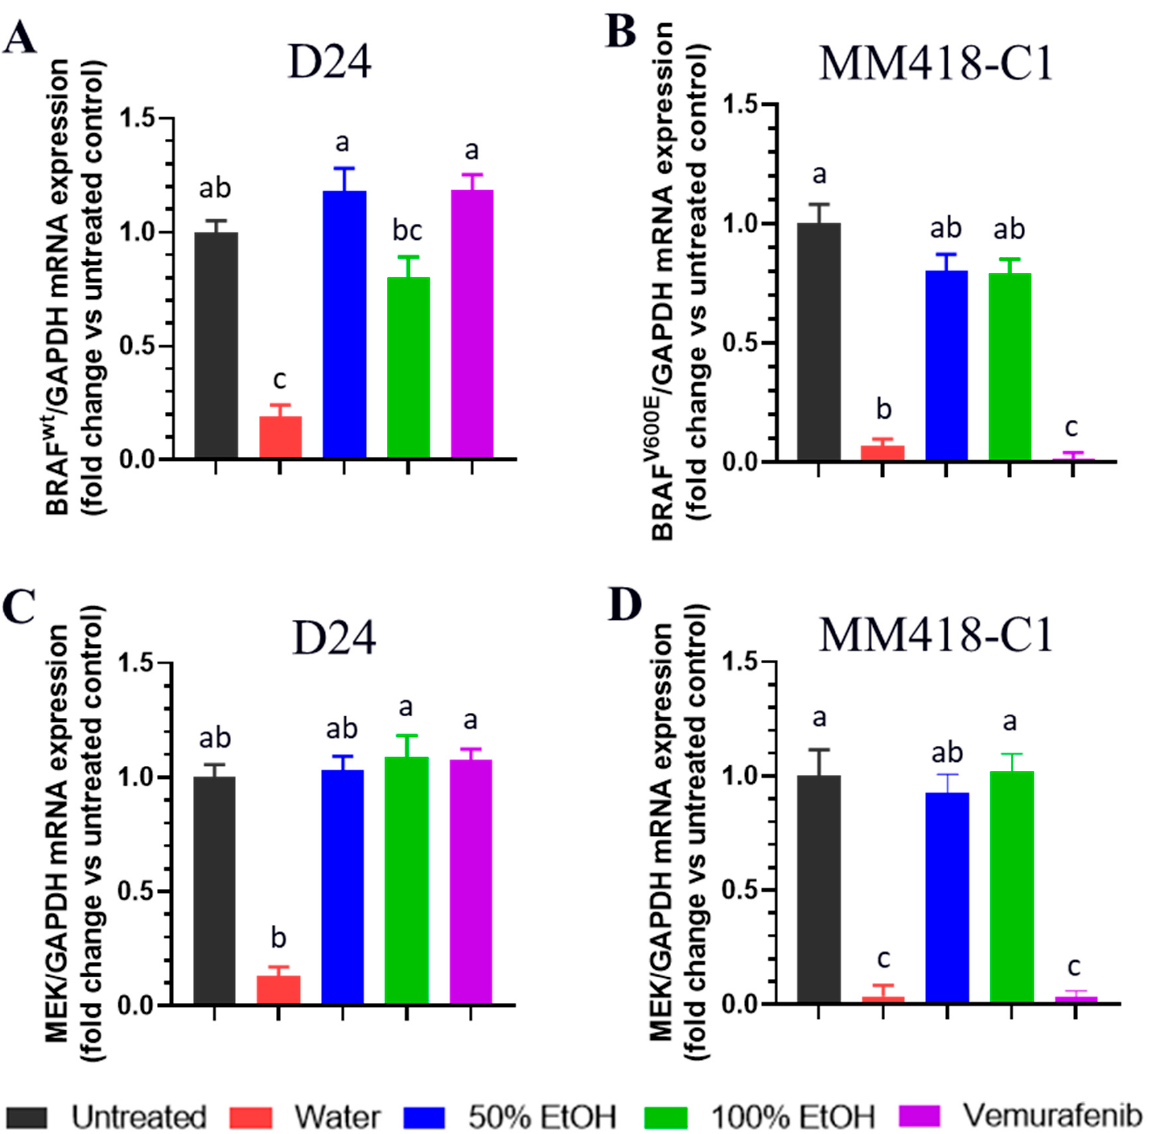
Figure 5. Effect of M. cochinchinensis seed extracts on the expression of BRAF WT gene in D24 ( A ), BRAF V600E gene in MM418-C1 ( B ), and MEK1 genes in D24 ( C ) and MM418-C1 ( D ) melanoma cells. The cells were treated with 100 µg/mL of the different seed extracts or vemurafenib for 48 h prior to RNA collection. Results were presented as the fold change compared to untreated controls ± SE, different letters indicated statistical significance at p ≤ 0.05 between different treatments (Analysis by One-way ANOVA with Turkey’s LSD test).